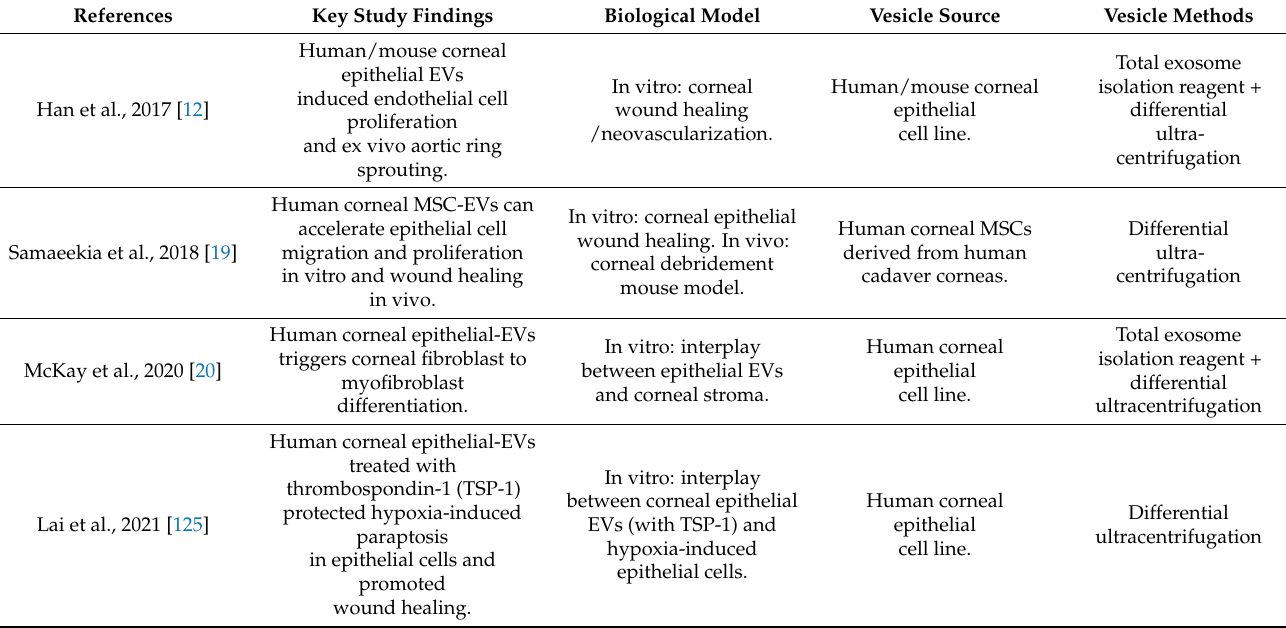
Table 2. Studies highlighting the roles of EVs in corneal wound-healing